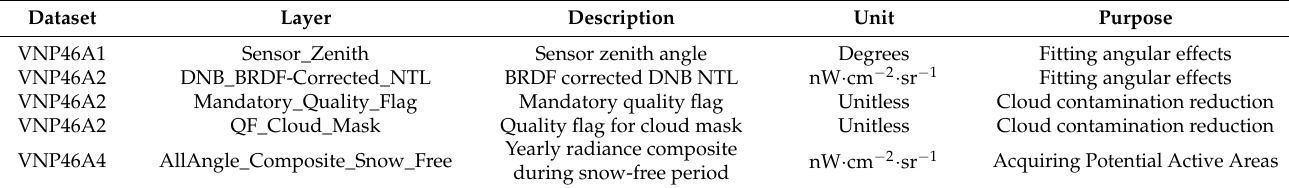
Table 1. All NTL datasets used in the study.